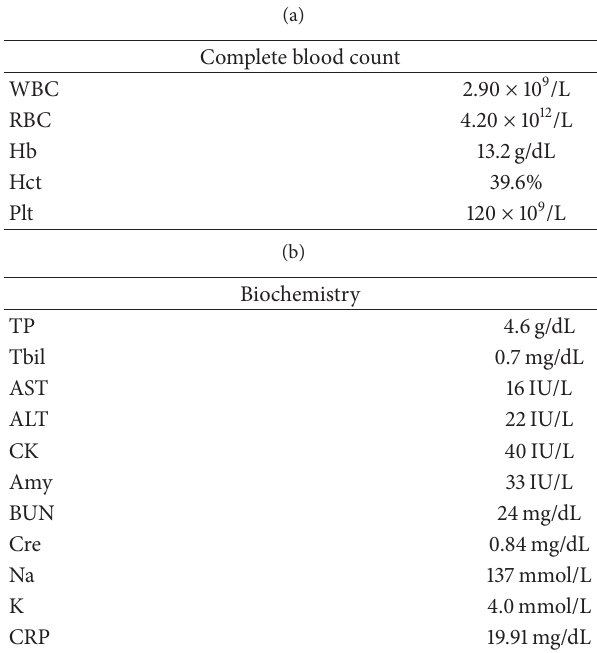
Table 1: Blood test